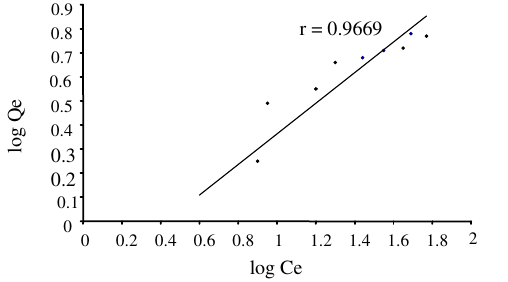
Figure 5. Freundlich isotherm of dye B with charcoal at pH 2